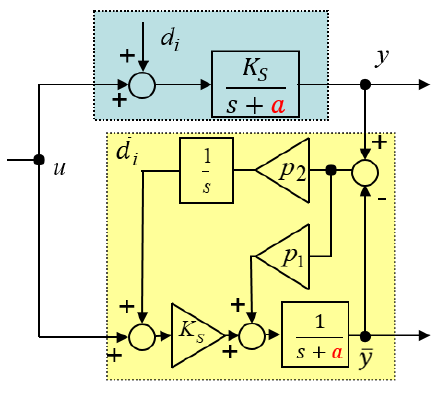
Figure 3. Extended state observer